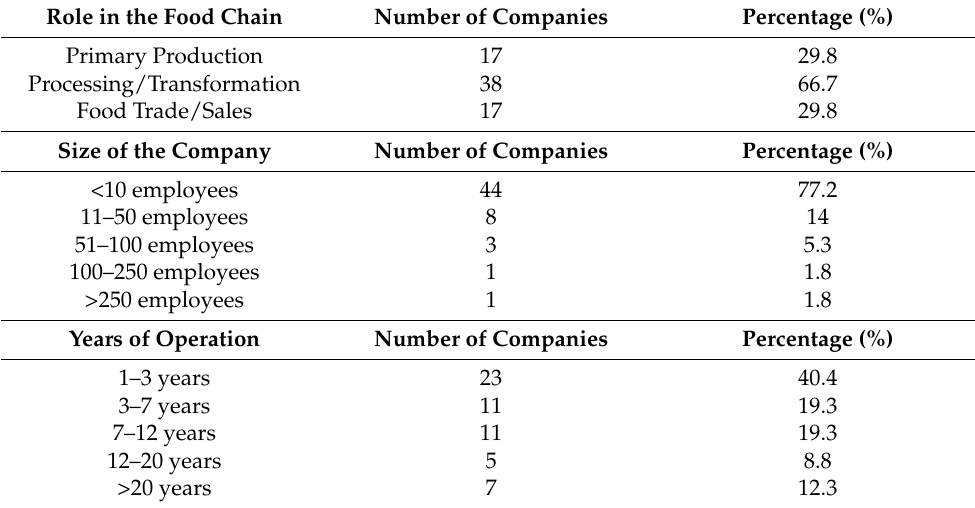
Table 3. Role, size, and years of operation of surveyed companies.